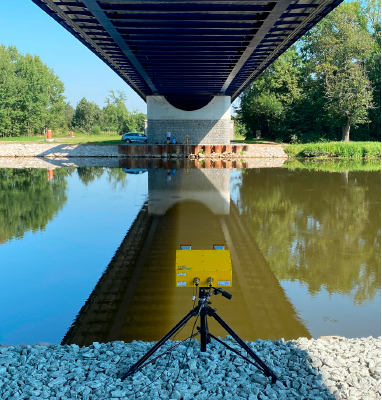
Figure 13. A view of the steel crossbeams of the bridge from the position of the R2 radar (near Valy municipality). The crossbeams served as natural signal reflectors.